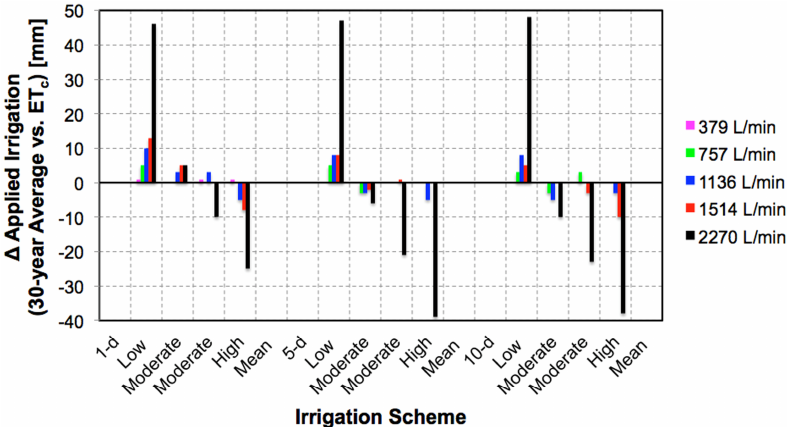
Figure 6. Difference of applied irrigation between the 30-year average and daily ET c (mm) as a function of irrigation scheme for the 1-day, 5-day and 10-day irrigation frequencies for Plainview, TX, USA. For each irrigation-frequency, the difference in applied irrigation between the 30-year average and daily ET c is plotted as a function of well capacity.